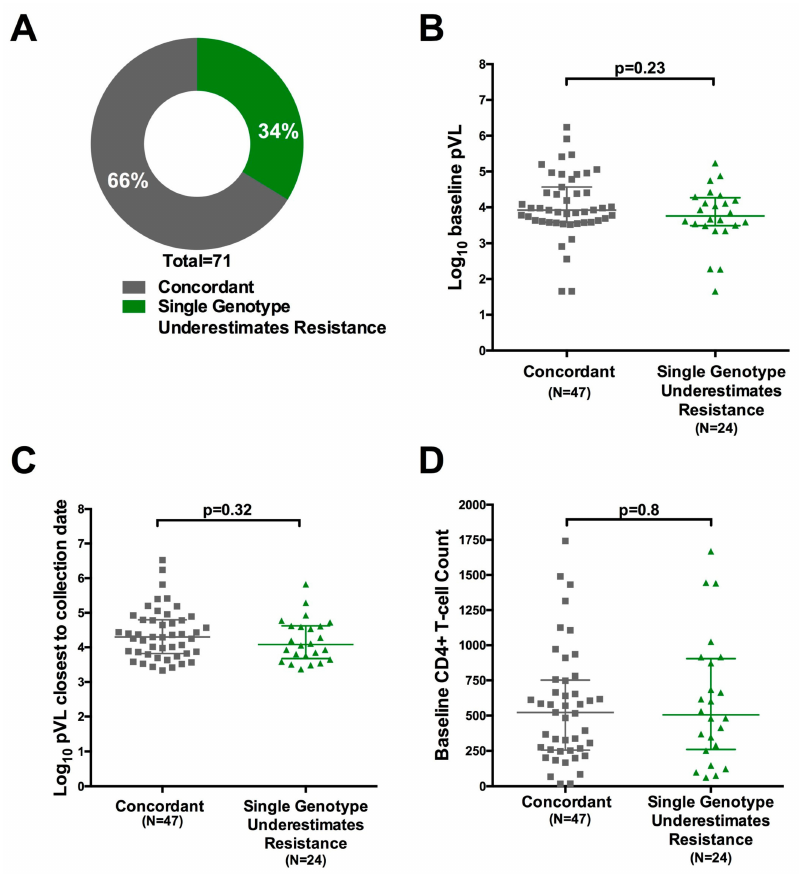
Figure 5. Impact of replicate genotyping on resistance interpretation: ( A ) Proportion of individuals for whom all replicate resistance genotypes were concordant at the individual drug level (grey) versus those where interpretation based on a single genotype would have underestimated the degree of resistance (green). Analysis was based on 71 participants for whom at least two replicate genotypes, derived from any amplification type, were available; ( B ) Log 10 baseline plasma viral load of participants for whom all replicate resistance genotypes were concordant (grey) versus discordant (green) at the individual drug level; ( C ) Same as ( B ); but for log 10 plasma viral load at failure ( D ) same as ( B ), but for CD4+ T-cell count at